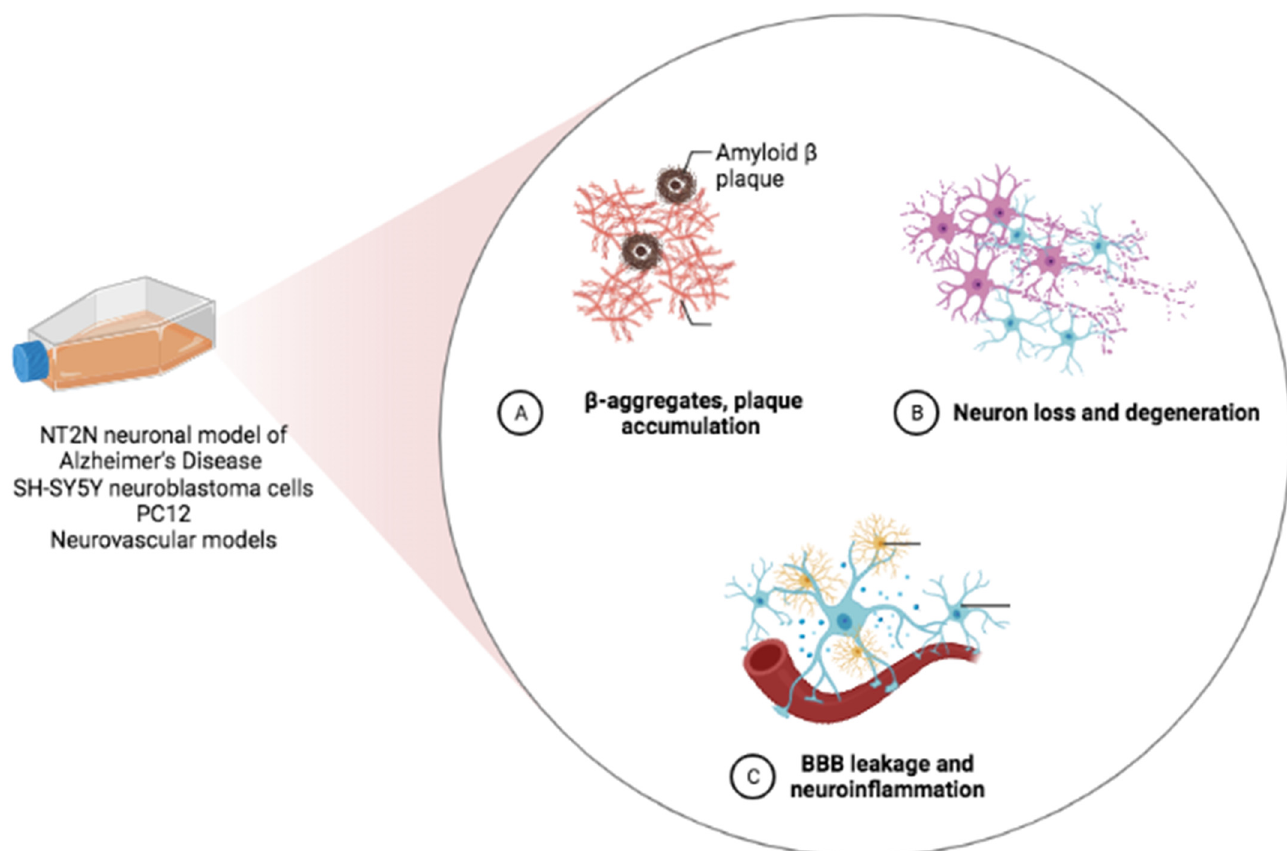
Figure 2. In vitro models recapitulating the neuronal dysfunction, synapse and dendrite loss that form the anatomic basis for cognitive decline (created in BioRender.com).